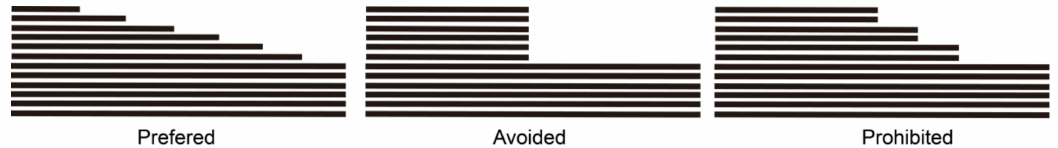
Figure 13. Different transition